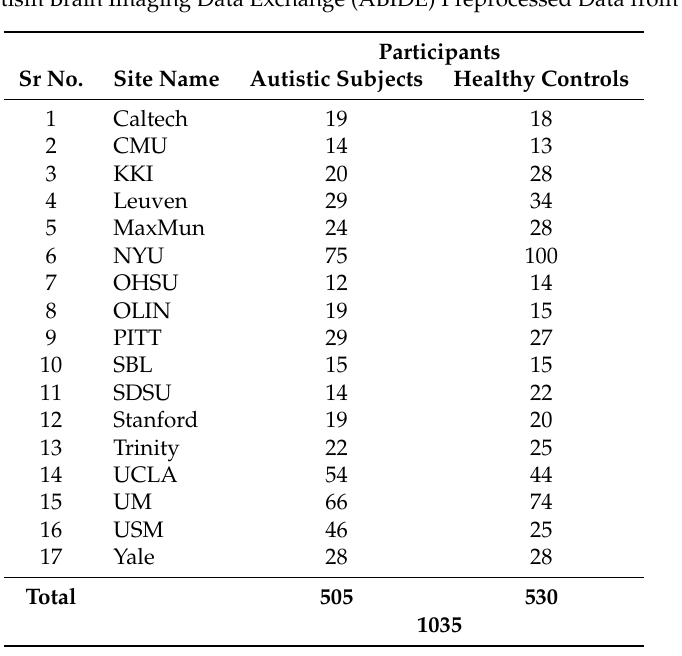
Table 1. Autism Brain Imaging Data Exchange (ABIDE) Preprocessed Data from all